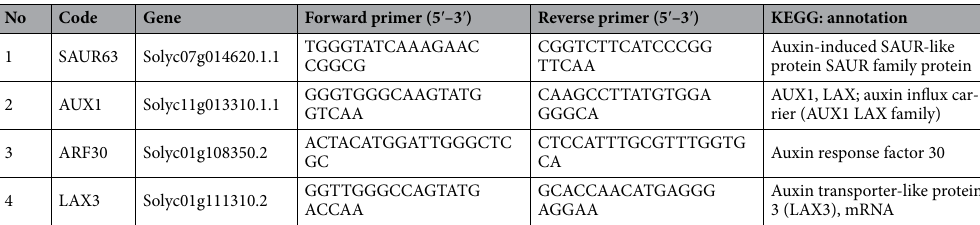
Table 1. The primer sequences of genes related to the Auxin hormone signaling